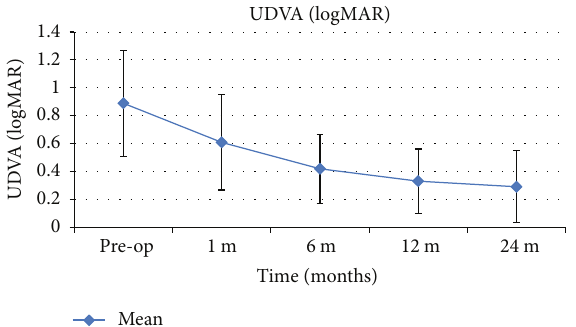
Figure 1: Mean UDVA over time. The error bars represent the SD in logMAR (UDVA: uncorrected distance visual acuity).